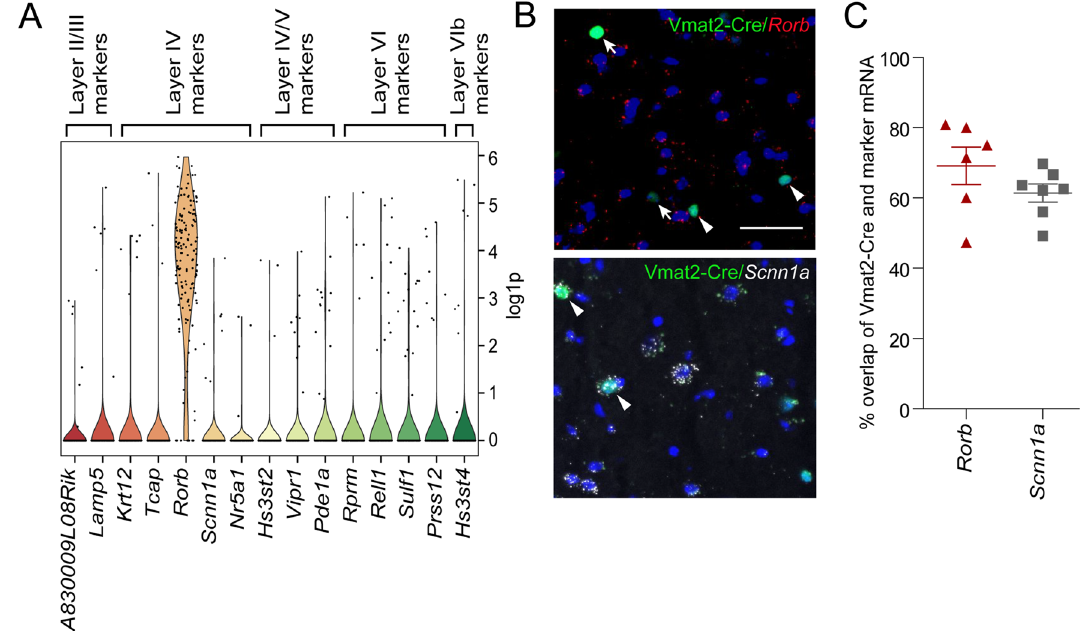
Figure 4. The IV layer marker Rorb is expressed by the majority of Vmat2-Cre neurons. ( A ) Violin plot of the expression of Zeisel et al. cortical layer markers in the Vmat2-Cre; tdTomato population (gene considered expressed if log1p ≥ 0.25). The image was generated using SCANPY, https ://scanp y.readt hedoc s.io/en/stabl e/. ( B ) RNAscope detection of the SB1F Vmat2-Cre.HTB (green) expression of layer IV markers Rorb (red) and Scnn1a (grey) (scale bar 100 µm). Arrowhead indicates Vmat2-Cre.HTB neuron expressing targeted gene and arrow indicates Vmat2-Cre.HTB neuron not expressing the targeted gene. The images were generated using Fiji (ImageJ 1.52f.), https ://image j.net/Welco me. ( C ) Scatter plot showing the percentage of adult Vmat2-Cre.HTB neurons that express the targeted layer IV marker gene ± SEM. The image was generated using GraphPad